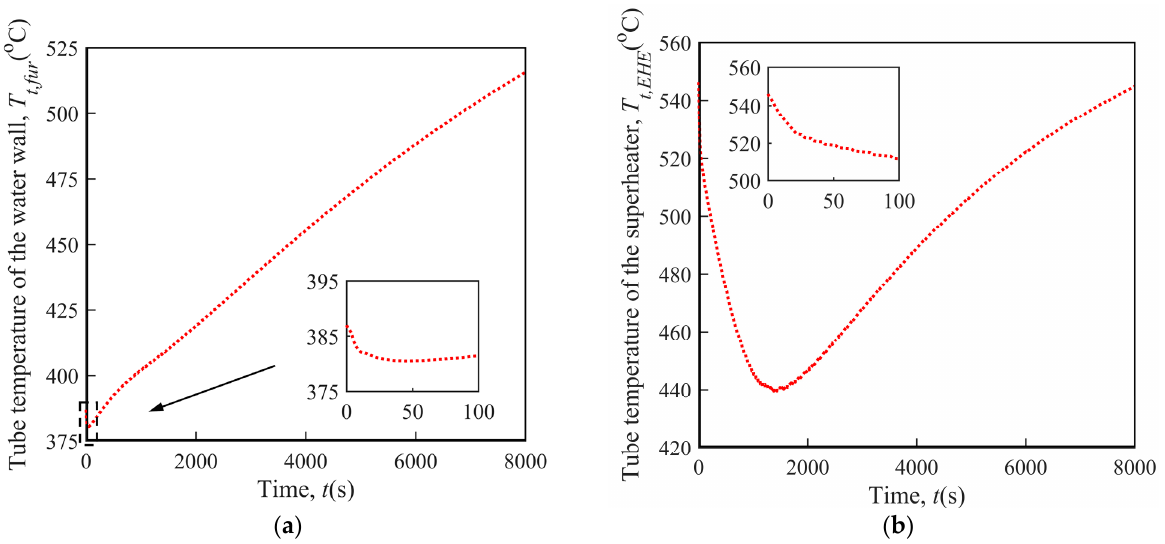
Figure 6. Variation of tube temperature under sudden electricity failure. ( a ) Water wall; ( b )